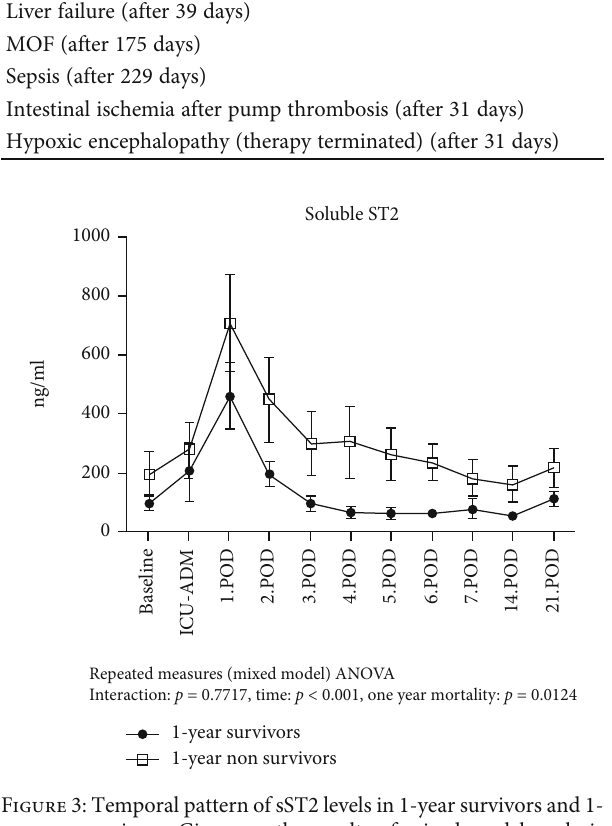
Table 4: Causes of death ( n = 7 ) and time to death. Stroke (after 86 days) Intracranial bleeding (after 236 days) Liver failure (after 39 days)